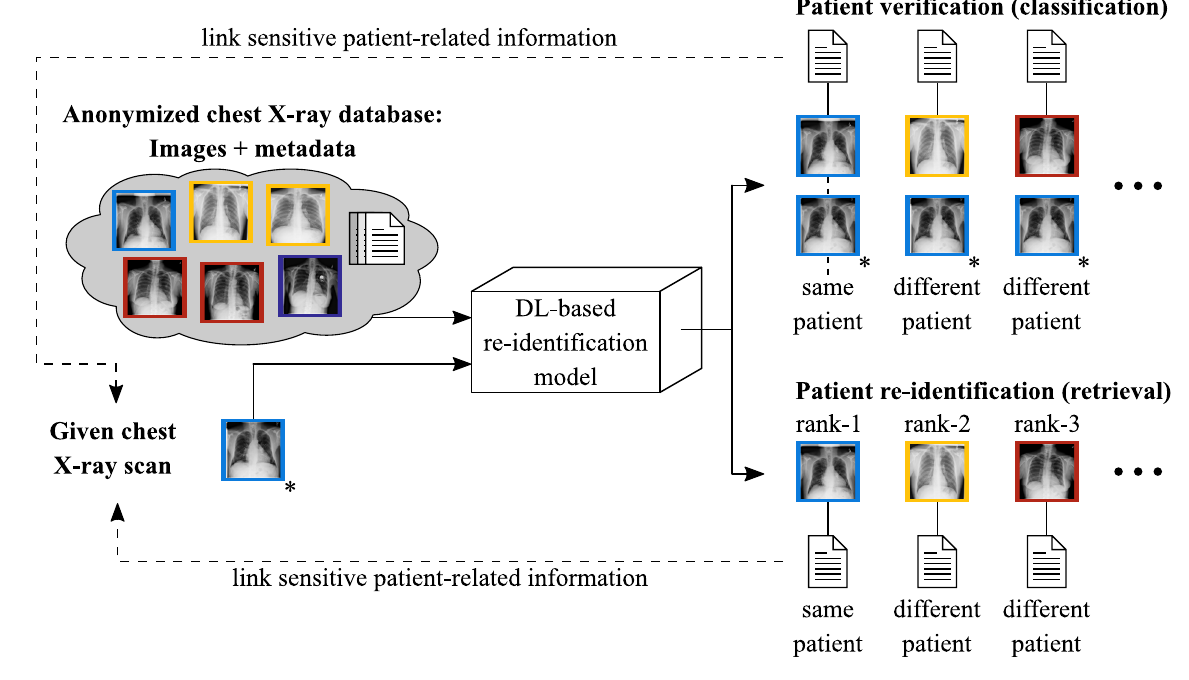
Figure 1. General problem scenario: Comparing a given chest radiograph to publicly available dataset images by means of DL techniques would either result in discrete labels indicating whether or not the dataset images belong to the same patient as the given radiograph (verification scenario) or yield a ranked list of the most similar radiographs related to the given scan (retrieval scenario). Images belonging to the same patient are highlighted with the same color. The given radiograph is marked with an asterisk. The shown cases would enable a potential attacker to link sensitive patient-related information contained in the dataset to the image of